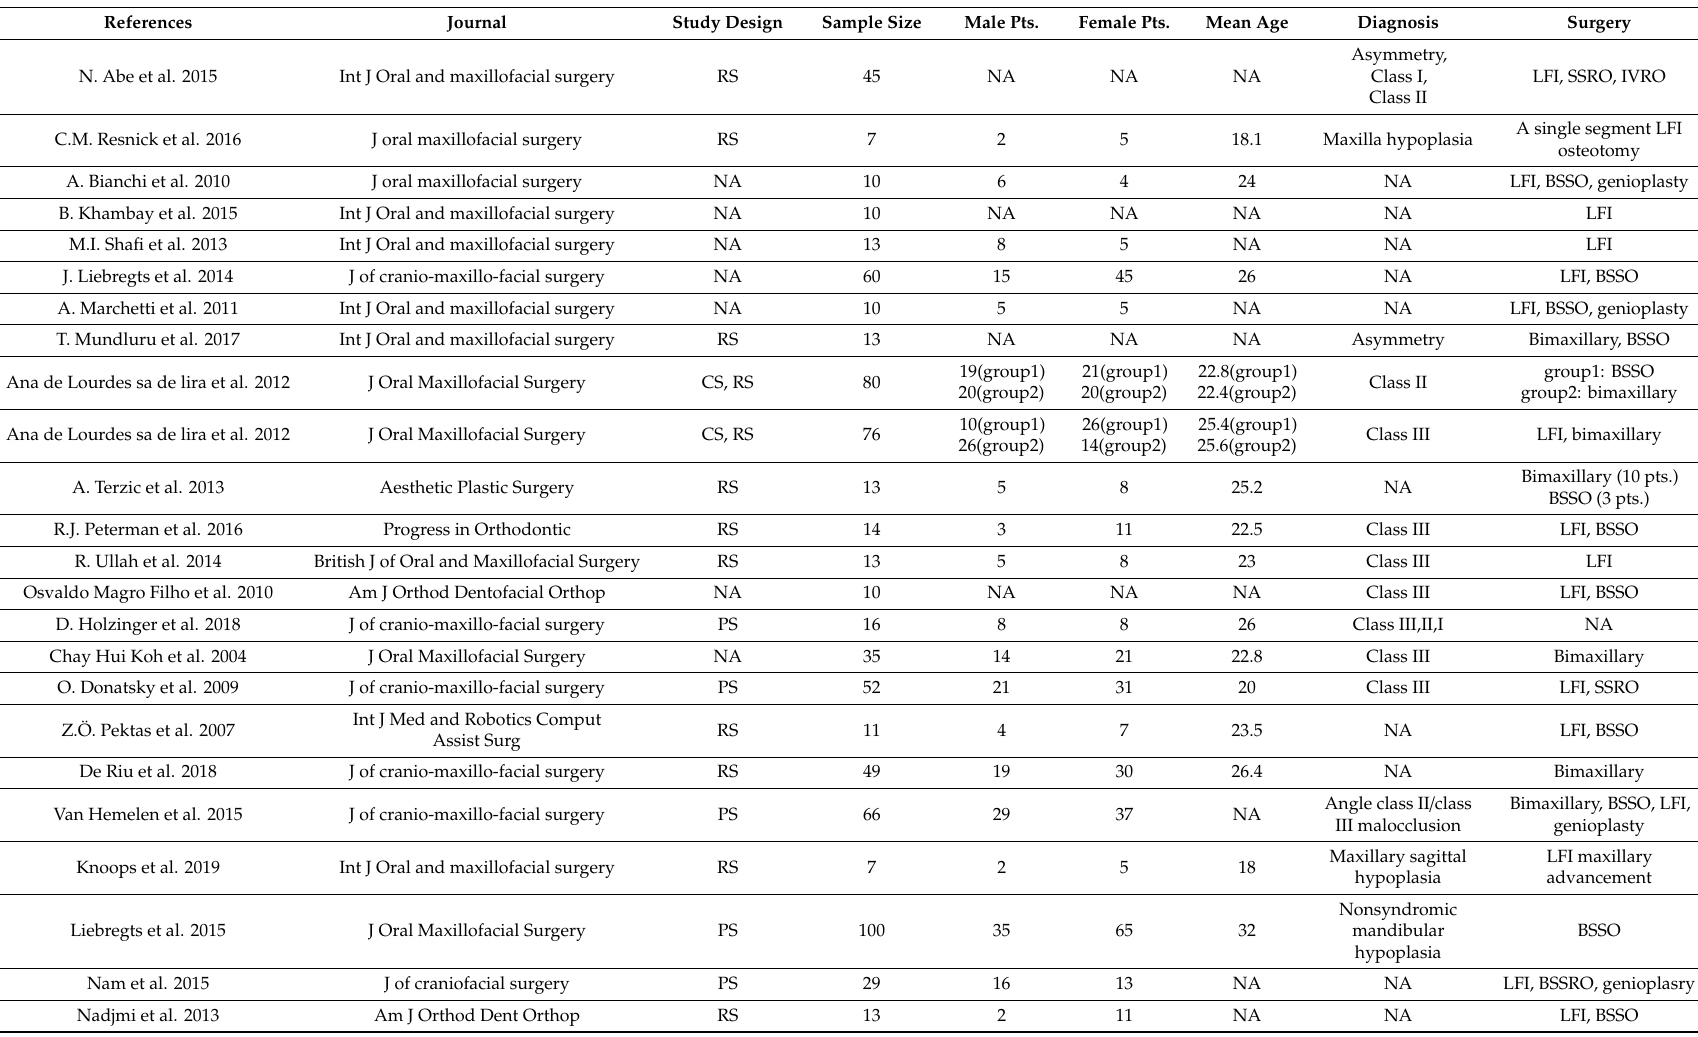
Table 2. Demographic details of patients (acronyms: PS is prospective study, RS is retrospective study, CS is case series study, NA is not available / not